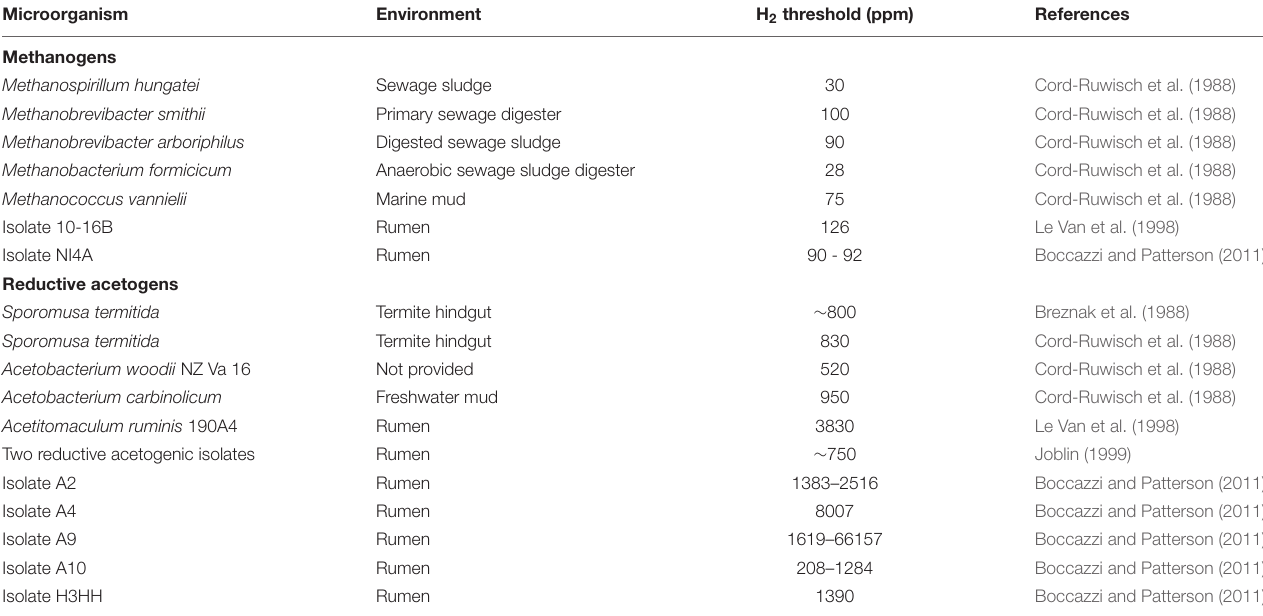
TABLE 3 | Dihydrogen thresholds of methanogens and reductive acetogens from the rumen and other environments.